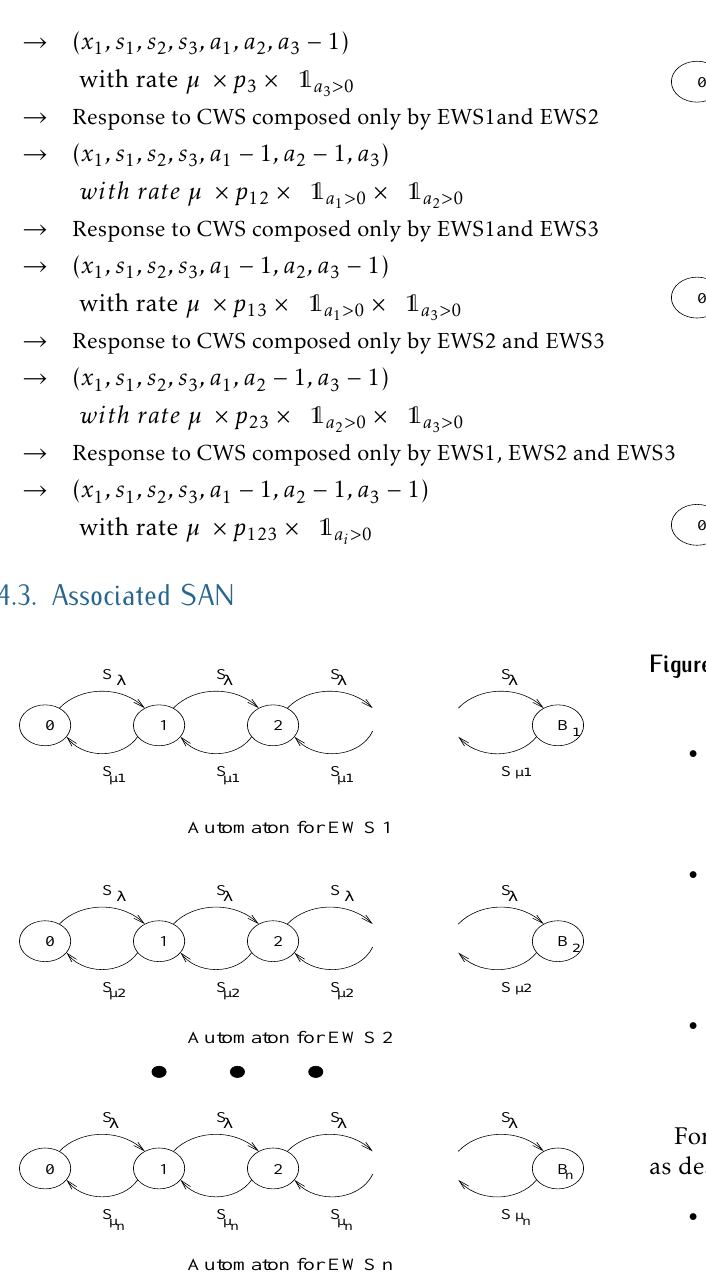
Figure 2. stochastic Automata for elementary service execution